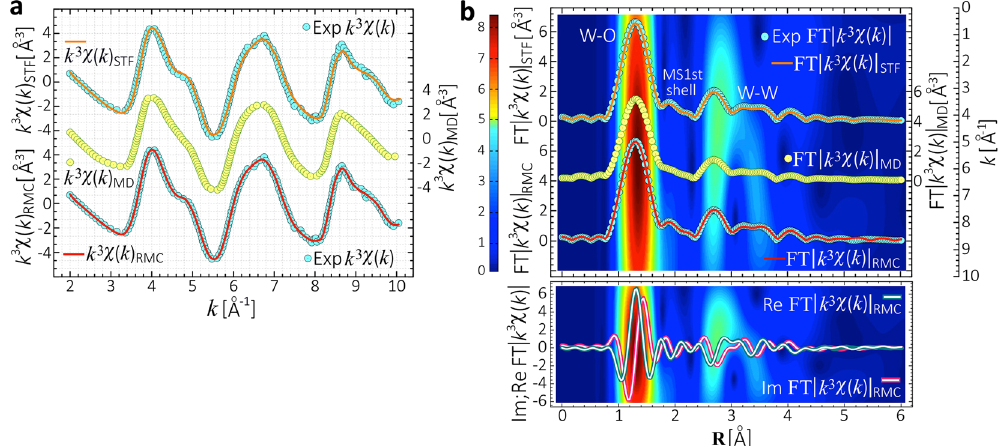
Figure 1. Experimental and simulated EXAFS spectra. ( a ) Top : Experimental EXAFS spectrum χ k k ( ) 3 of a WO 3 [phase-uncorrected] and its corresponding standard nonlinear least-squares spectral fitting χ k k ( ) 3 . Middle : STF The ab - initio FMS computed χ k k ( ) 3 function. Bottom : Experimental EXAFS spectrum χ k k ( ) 3 of a WO 3 and MD its corresponding RMC-EXAFS simulated χ k k ( ) 3 function. ( b ) Background : Wavelet-transform [WT] of the RMC χ k k ( ) 3 spectrum. Top : The Fourier-transform FT χ k k ( ) 3 of the experimental EXAFS spectrum and its corresponding standard nonlinear least-squares spectral fitting FT χ k k ( ) 3 . Middle : The ab - initio FMS STF computed FT χ k k ( ) 3 function. Bottom : Experimental FT χ k k ( ) 3 spectrum and its corresponding RMC- MD EXAFS simulated FT χ k k ( ) 3 function. Lower panel : The Real and Imaginary components for the RMC experimental FT χ k k ( ) 3 [thick line], and for RMC-EXAFS simulated FT χ k k ( ) 3 spectra [thin RMC